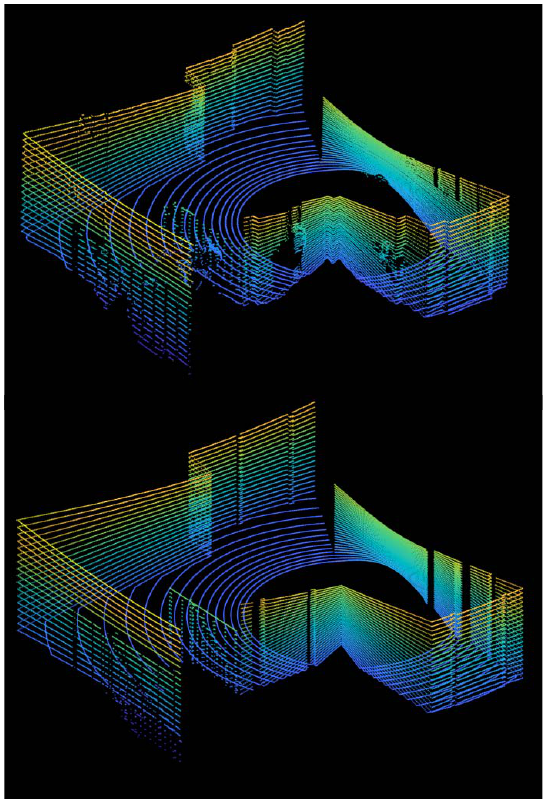
Figure 2. A real lidar point cloud (top) and the corresponding synthetic point cloud (bottom)